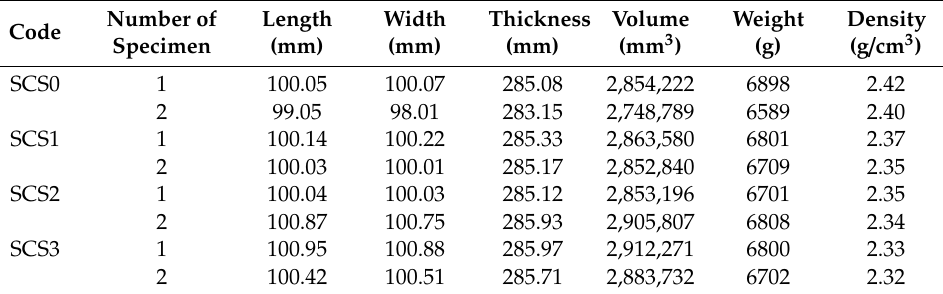
Table 5. Average dimensions and weight of the shrinkage